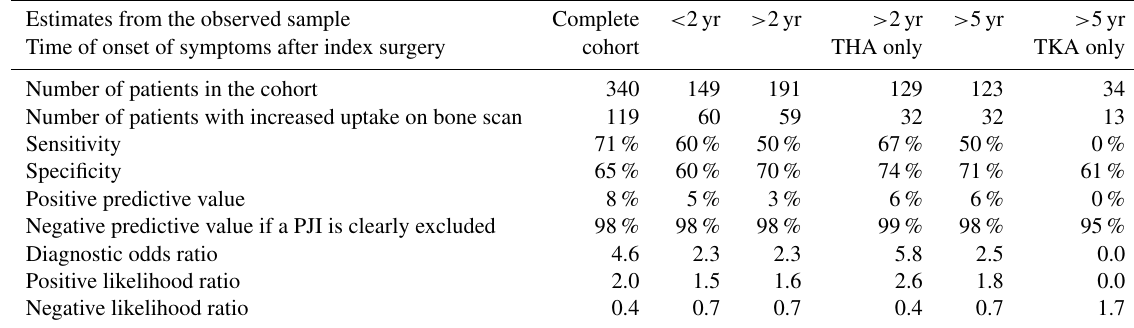
Table 4. Diagnostic accuracy of WBC scintigraphy and combination of TPBS/WBC scan for the diagnosis of a low-grade PJI. Estimates from the WBC Cohort WBC WBC WBC observed sample